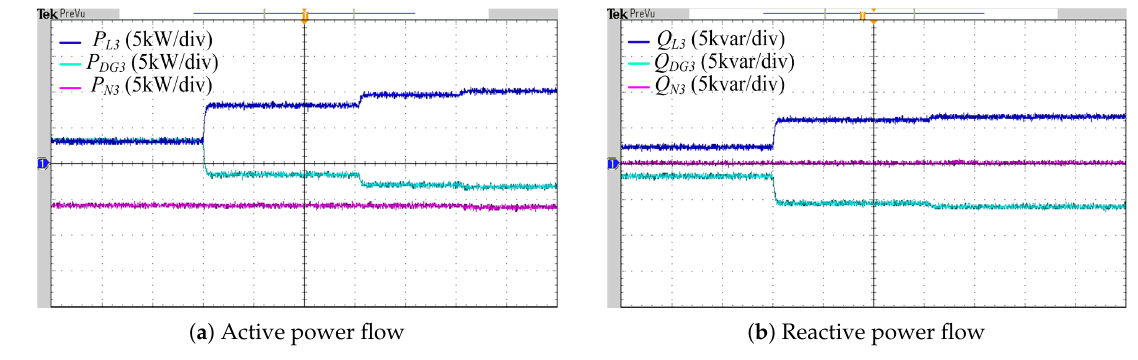
Figure 8. Power curves in Nanogrid-3.